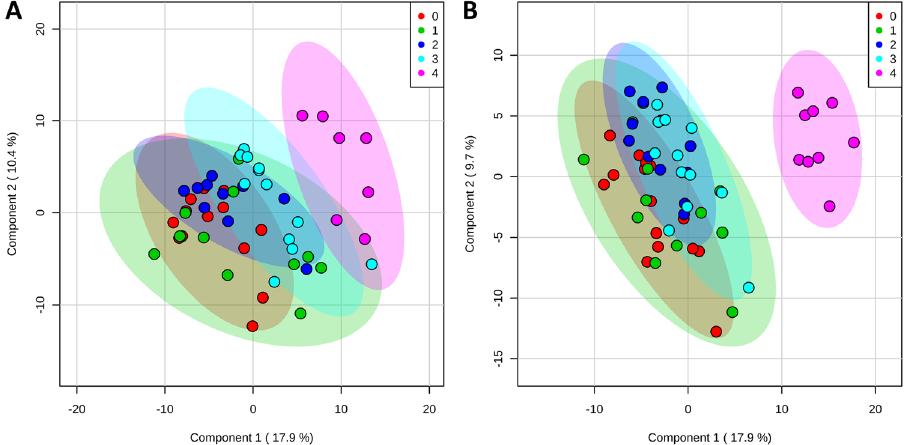
Figure 2. Partial Least Squares discriminant analysis (PLS-DA) scores plots of components one and two, comparing skin samples ( A ) and liver samples ( B ) as they cluster by sampling group. Sham-exposed negative control group frogs were designated Group 0. Exposed/infected frogs sampled at various times post-exposure were designated Groups 1, 2, 3 and 4, corresponding to being sampled at 4, 8, 14 and 28–30 days post exposure,